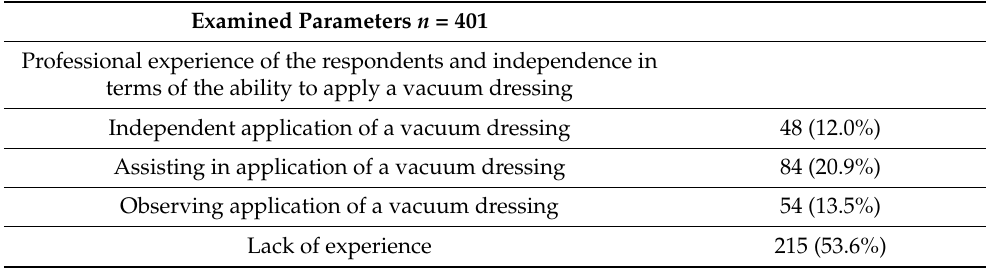
Table 4. Professional experience in terms of the ability to apply a vacuum